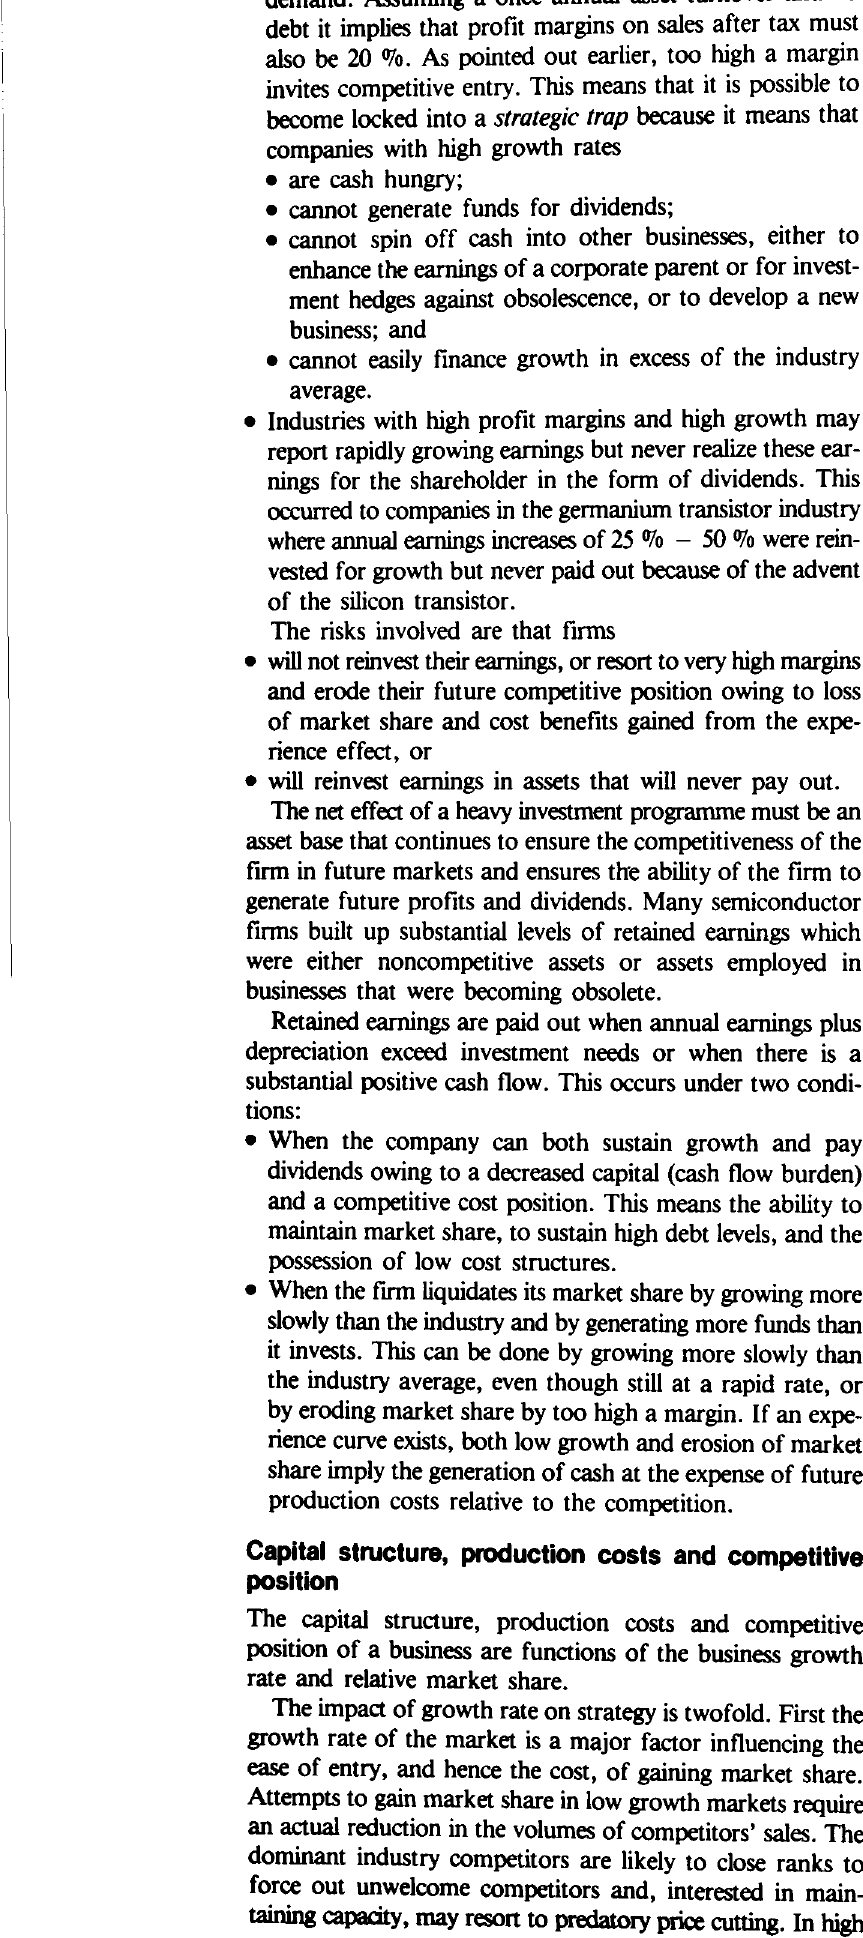
Figure 2 The strategic cost benefit associated with high market share in an experience-driven